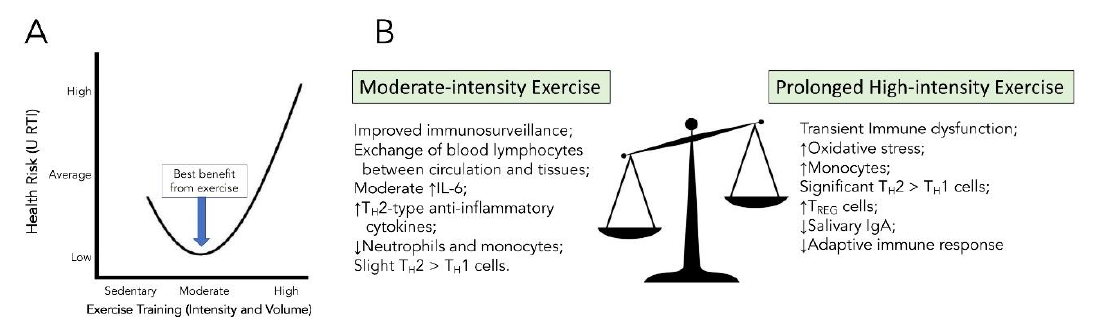
Figure 3. J-shaped curve of upper respiratory tract infections (URTI) risk versus exercise training (Panel A ) and balancing the positive benefits and negative effects of exercise intensity on the immune system (Panel B ).